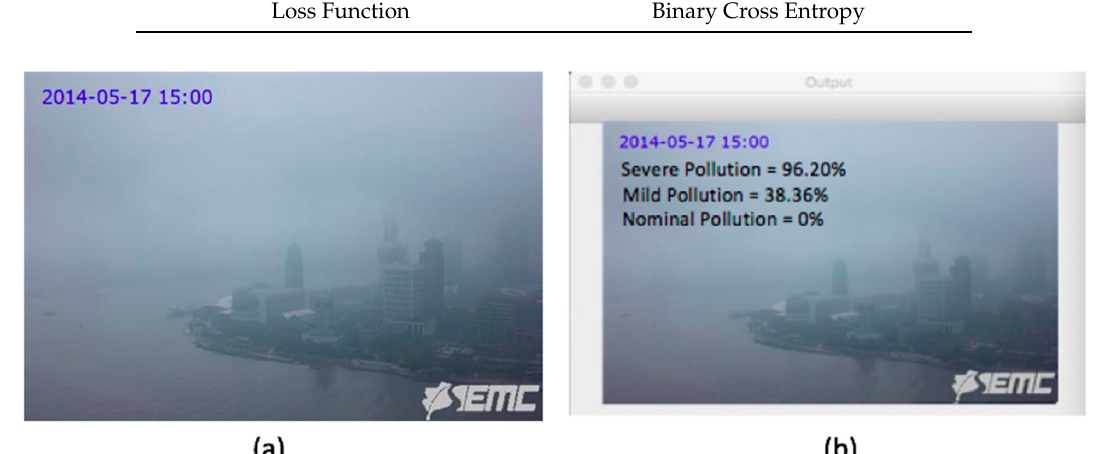
Figure 2. Image of Shanghai city, China captured by a camera on 17 May 2014 at 15:00 h: ( a ) original image captured by the camera; ( b ) VGG Net shows its predictive output label on the same image.